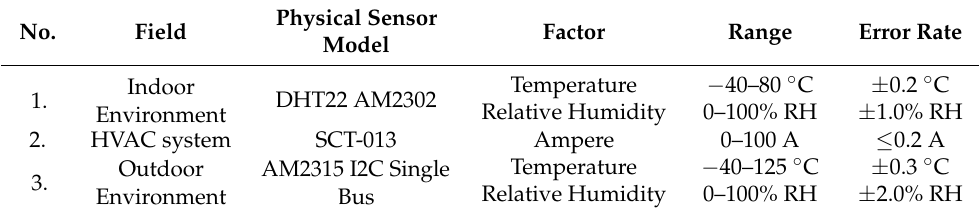
Table 3. The sensor models and their functions in interdisciplinary fields.